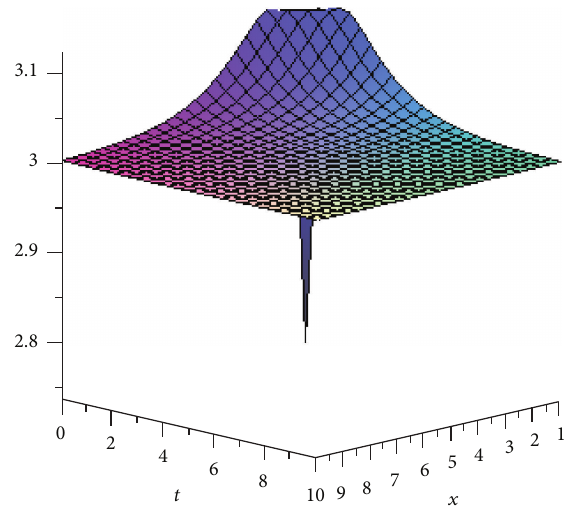
Figure 3: The solution 𝑊 3 in (34) with 𝛾 = 4/5 , 𝑘 = 𝑐 = 𝜎 = 𝑏 2 = = 1 , 𝜇 = −1 , 𝜉 𝑓 2